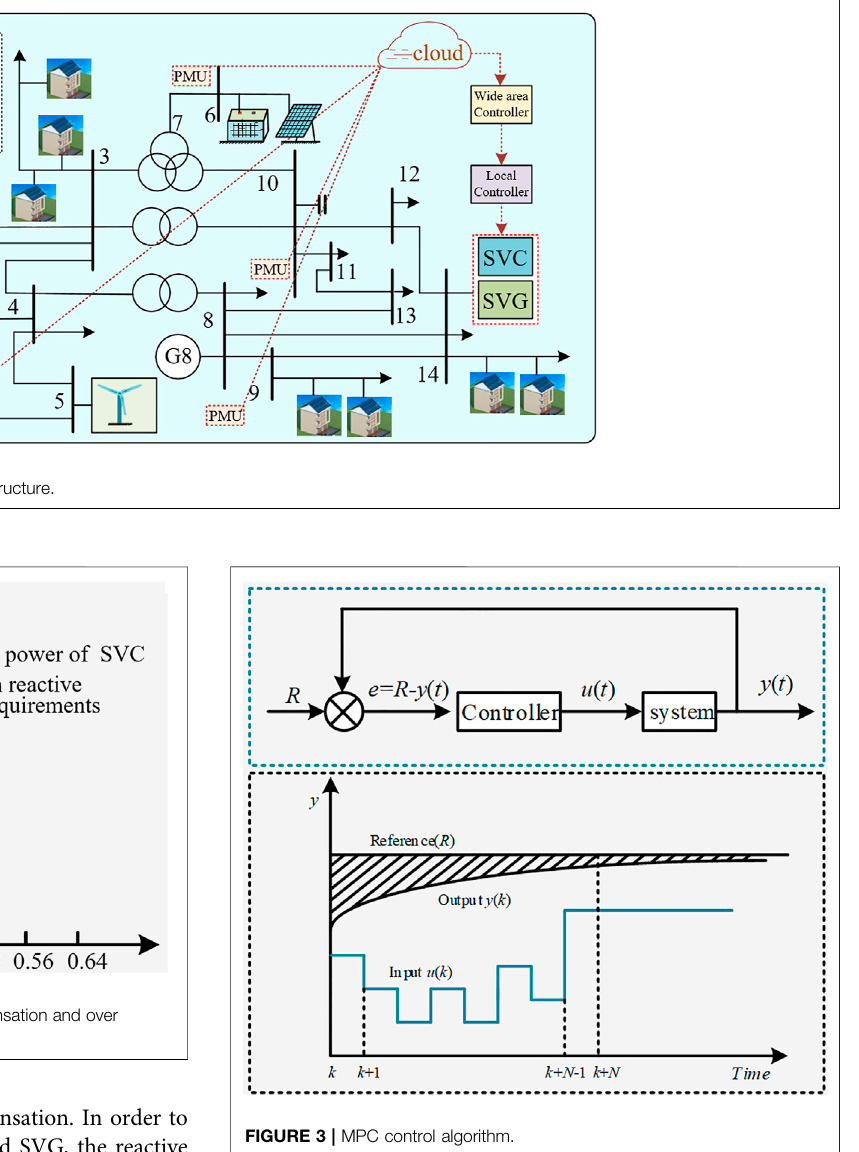
FIGURE 3 | MPC control